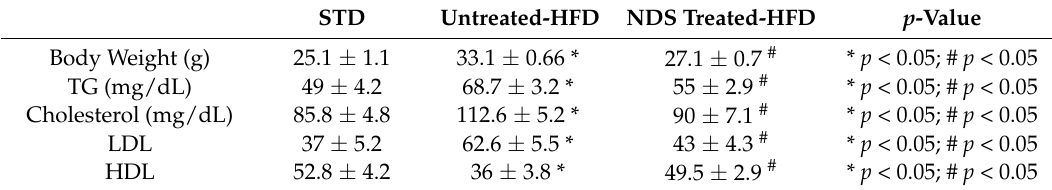
Table 2. Effects of natural dietary supplement (NDS) on high fat diet (HFD)-induced dysmetabolism. STD Untreated-HFD NDS Treated-HFD p -Value Body Weight (g)